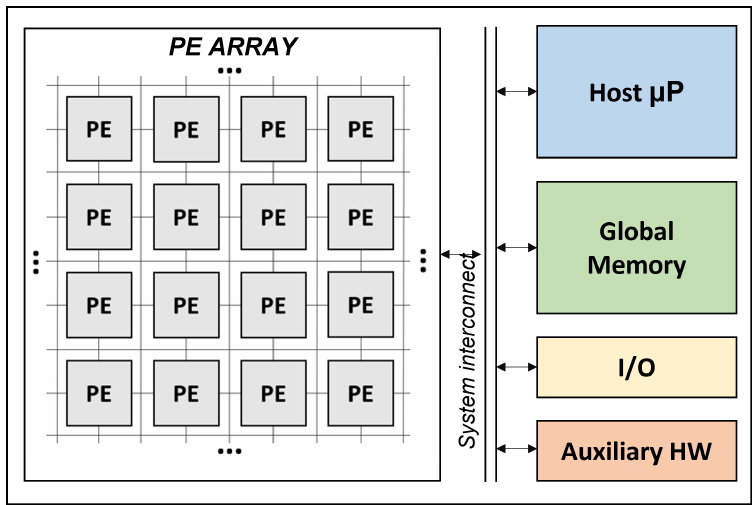
Figure 2. General model of CGRA systems. Host processor might be used only at configuration stage (standalone CGRAs) or throughout execution stage (for system control as well as